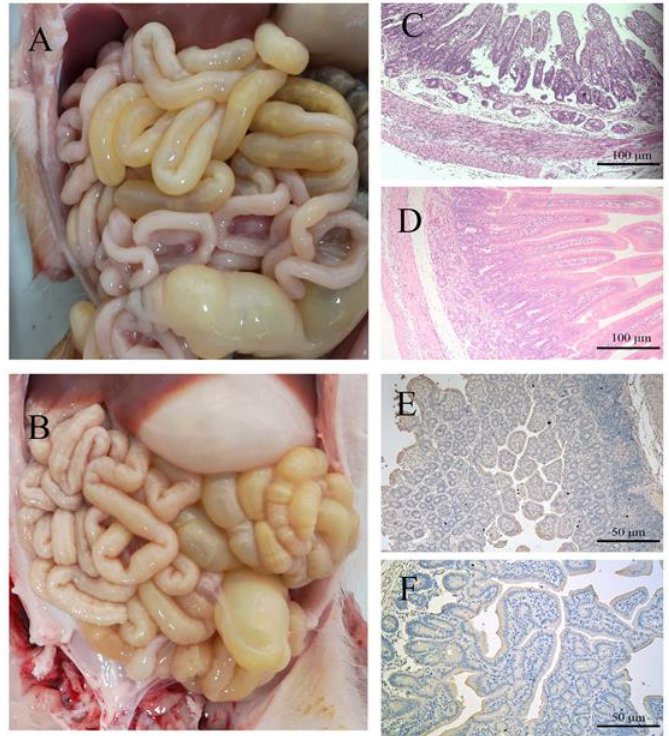
Figure 4. Intestinal changes of infected and uninfected piglets challenged with PDCoV CHN-JS-2017. ( A ) Macroscopic damage of piglets challenged with PDCoV at 4 dpi. ( B ) Macroscopic view of 4 dpi negative control piglets. ( C , D ) Hematoxylin and eosin (H&E)-stained jejunal tissue sections of piglets challenged with PDCoV ( C ) or negative control piglets ( D ). ( E , F ) Immunohistochemically stained jejunal tissue sections of challenged piglets ( E ) or negative control piglets ( F ).